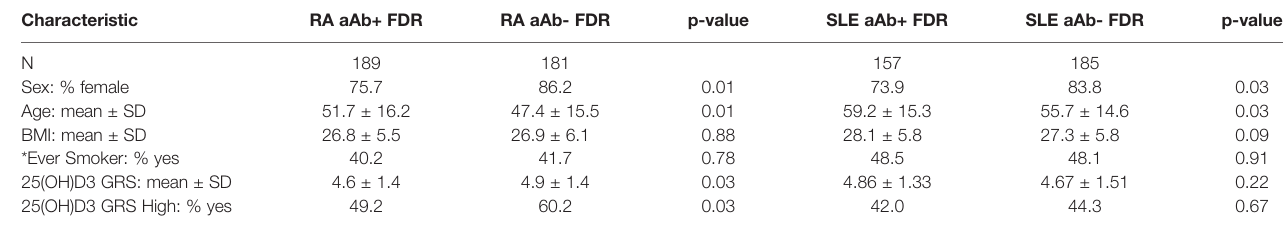
TABLE 1 | Demographic characteristics for the RA FDR and SLE FDR cohorts.